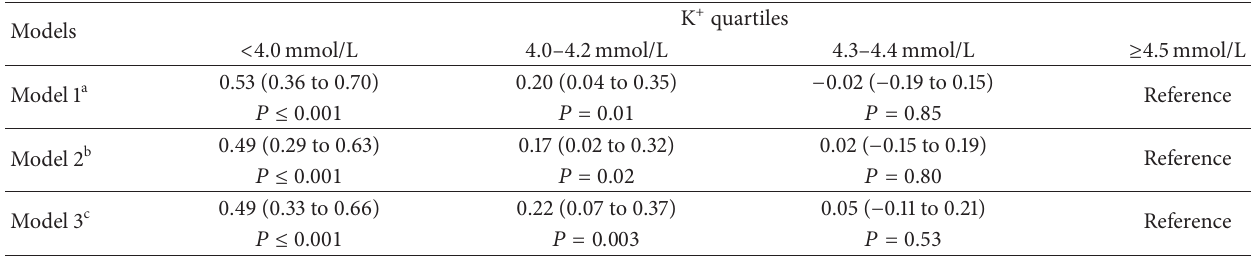
Table 2: Linear regression to determine the difference in 2-hour glucose across K + quartiles.